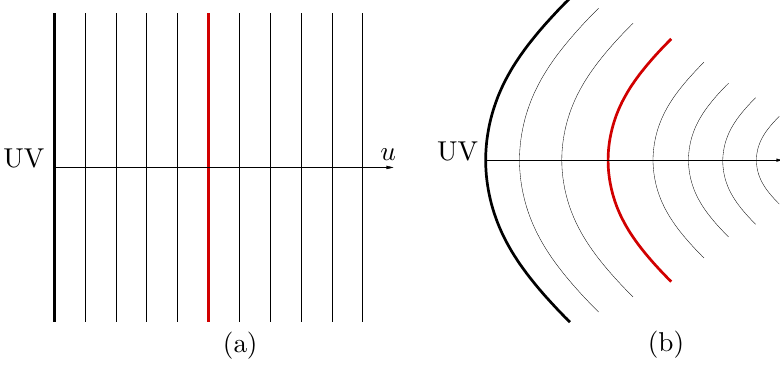
Figure 1 . A sketch of the solutions allowing for a (cid:13)at brane (a) and those allowing for a curved brane (b). The thick black line represents the conformal boundary of AdS, whereas the brane is represented in red. The direction u is the holographic direction, and the thin black lines are constant- u hypersurfaces. The brane metric is inherited from the UV boundary metric (up to a